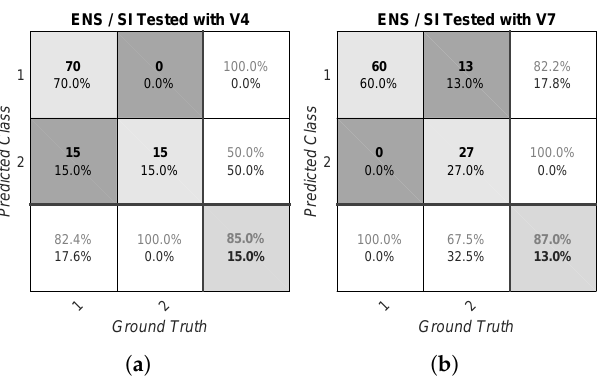
Figure 5. Confusion matrices for ENS classifiers and tested volunteers (unseen data) over their respective subject-independent models: ( a ) tested V4, ( b ) tested